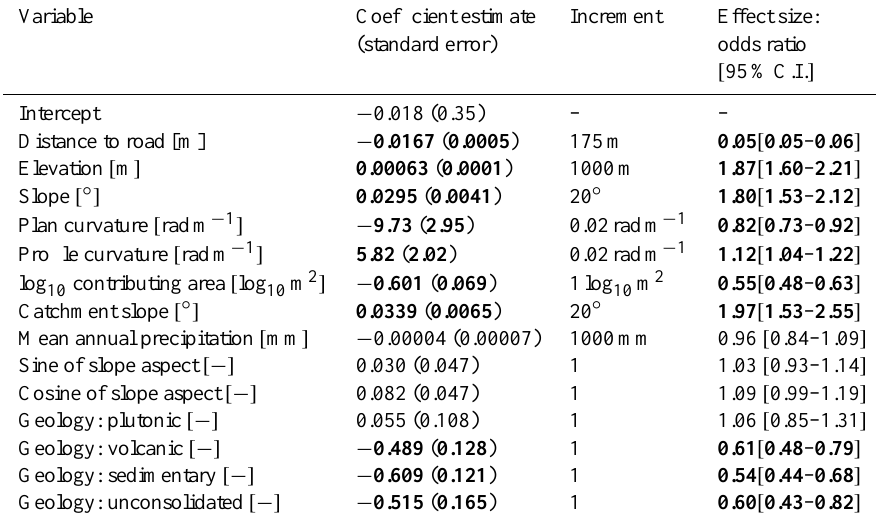
Table 3. Results of generalized linear modeling: coefficient estimates with standard errors (in parentheses), and odds ratios with 95% confidence intervals for meaningful increments of the predictors. Boldface indicates significant tests at the 5% significance level of the null hypothesis of the true coefficient being equal to zero against the two-sided alternative. Spatial autocorrelation and multiplicity of tests are unaccounted for.